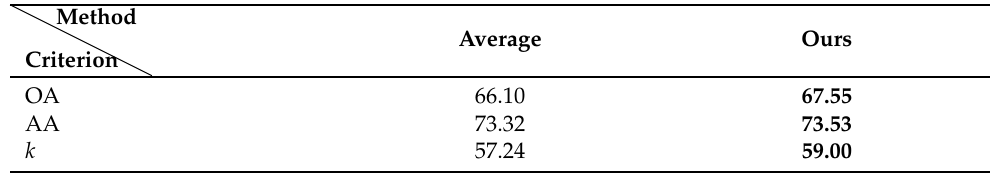
Table 11. Classification accuracy of 3D-CNN with five training samples via average and ours on the PaviaU dataset